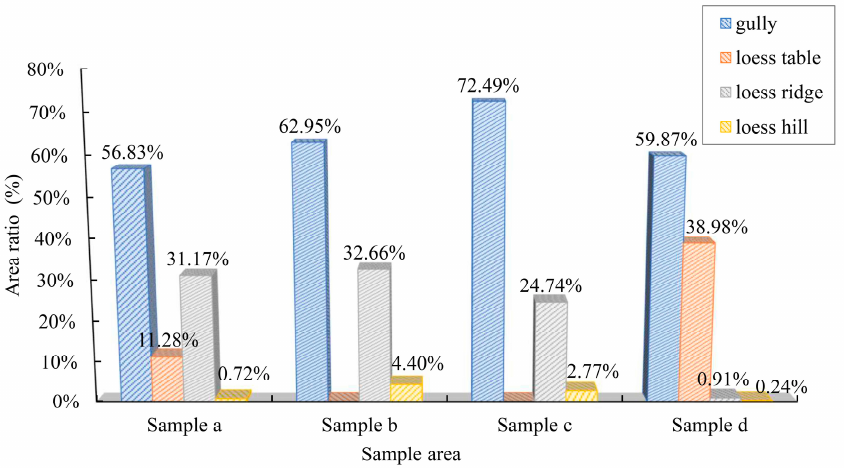
Figure 8. The area proportion of loess landform types in different sample areas.